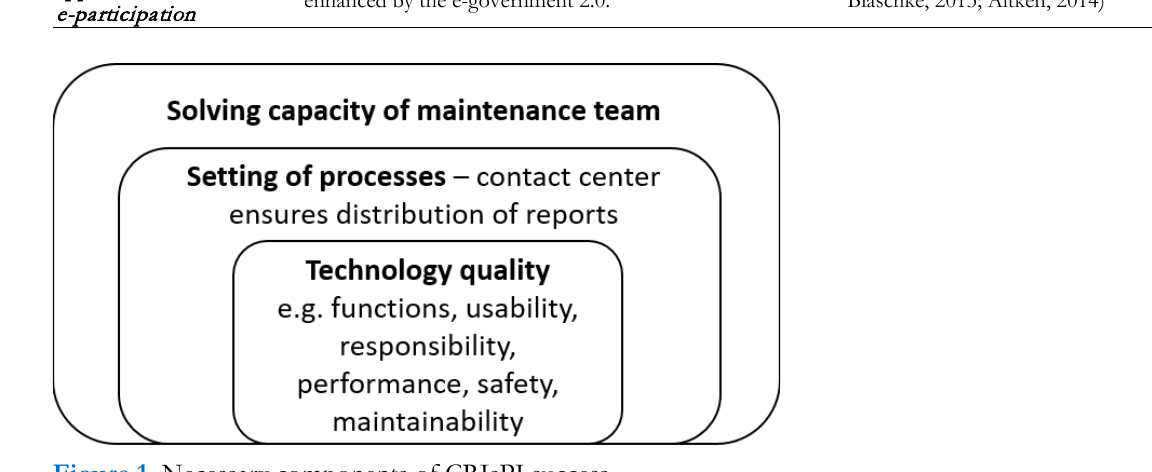
Figure 1. Necessary components of CRIsPI